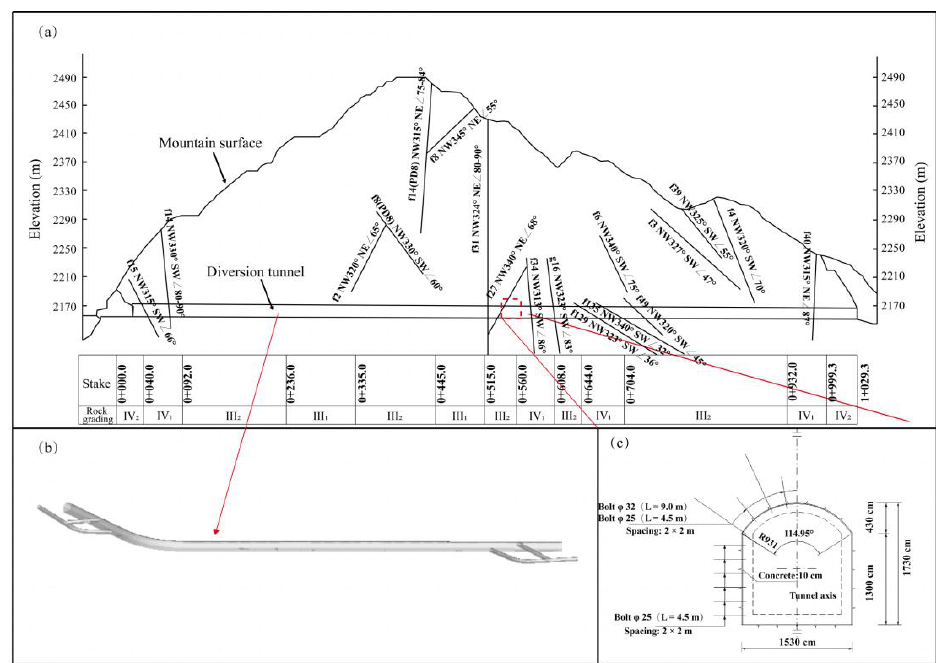
Figure 2. Tunnel profile. ( a ) Profile information; ( b ) 3D model; ( c ) typical section of the diversion tunnel.